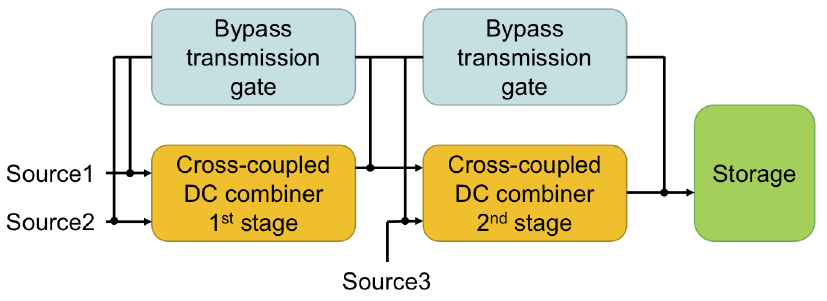
Figure 23. The concept adder combiner presented in